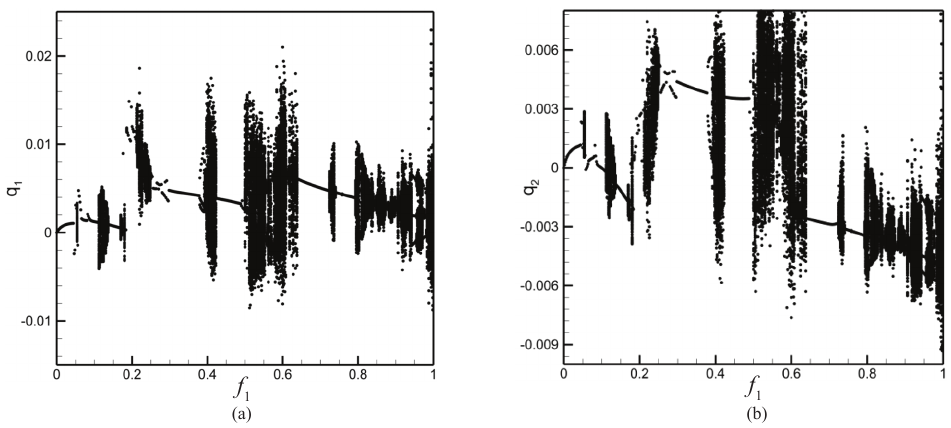
Fig. 20. Bifurcation diagrams of Poincaré points for increasing forcing amplitude on the system with γ T = 1 . 5